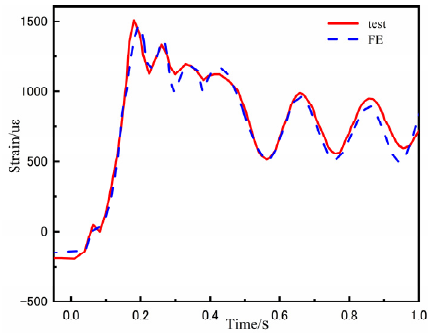
Figure 8. LC1 strain time history.